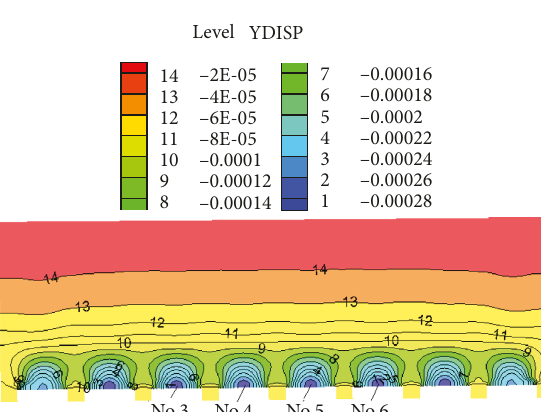
Figure 5: Displacement isoline map in the Y direction.